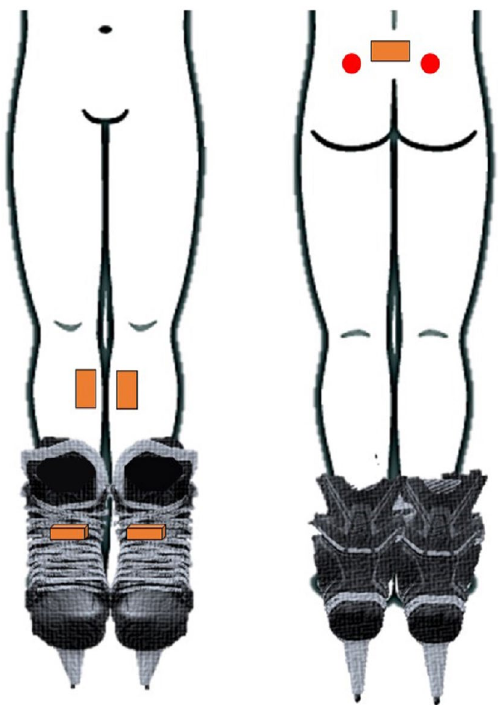
Figure 1. Five IMUs (orange boxes) were placed on the participants’ pelvis, shanks and skates. Also, two pressure insoles placed in the skates and two retro-reflective markers on the PSISs (red circles) were used as a reference system for temporal event detection and stride length estimation,